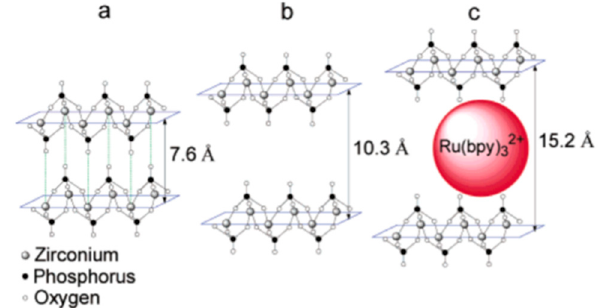
Figure 6. Schematic representation of ( a ) α -ZrP ( b ) θ -ZrP and ( c ) [Ru(bpy) 3 ] 2 + -exchanged ZrP. Reproduced from [13], with permission from the American Chemical Society, 2003.